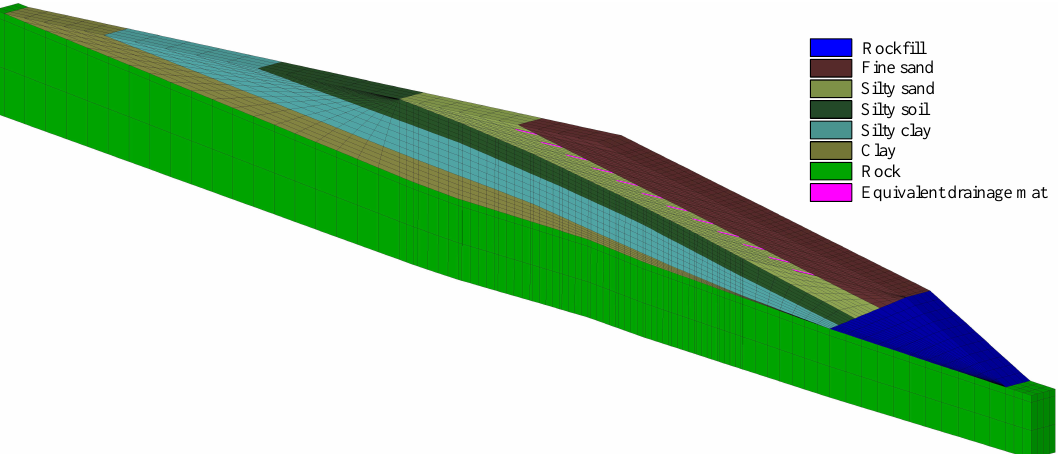
Figure 10. The quasi-3d finite element mesh of the tailings dam with equivalent drainage structure and the tailings distribution in the